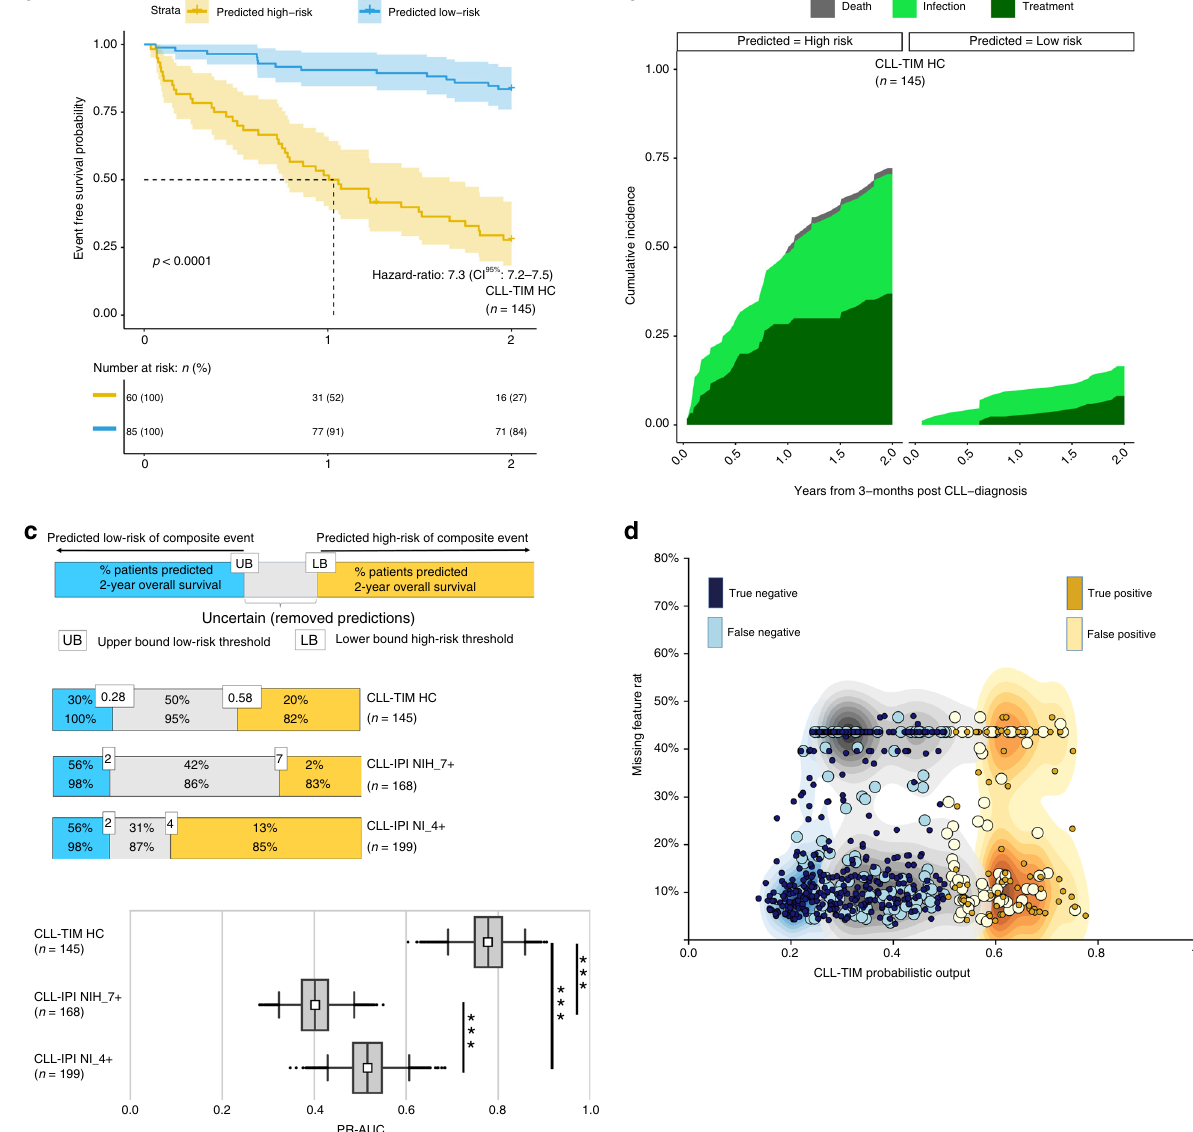
Fig. 3 CLL-TIM benchmarking on internal test cohort. a Kaplan – Meier graphs of infection-free, CLL treatment-free survival for CLL-TIM high-con fi dence (HC) predicted high-risk (yellow curve with 95% con fi dence intervals) and low-risk groups (blue curve with 95% con fi dence intervals) on a subset of the internal test cohort (BENCH-I, n = 288 with n = 145 high-con fi dence predictions). Patients in BENCH-I have full CLL-IPI and a full 2-year follow-up. p -value is by log-rank test. b Cumulative incidence plots for CLL-TIM HC predicted high-risk and low-risk groups for CLL treatment (dark green), infection (bright green) and death (grey) as fi rst events on BENCH-I. c Two-year outcome PR-AUC (Precision-Recall Area-Under-Curve) for CLL-TIM and CLL-IPI on BENCH-I. To allow for an equitable comparison, CLL-TIM HC (i.e. with removal of uncertain predictions) was benchmarked against an additional two versions of CLL-IPI score; CLL-IPI with removal of patients in the intermediate-risk category, CLL-IPI NI_4 + , and CLL-IPI with removal of the intermediate and high-risk category, CLL-IPI NIH_7 + . For box-and-whisker plots, whiskers are 95% con fi dence intervals generated using 5000 bootstrapped datasets sampled from each respective cohort (See Methods), white square is the mean, centre line is the median, bounds of box are the interquartile range and black dots are outliers. We performed model comparison using a one-tailed Mann – Whitney U-test on the mean difference of the PR-AUC over the bootstrapped datasets. *** indicates p < 0.0005. d Average missing feature rate for patients in internal test cohort. Shaded distributions are blue – low-risk high-con fi dence predictions, gray – low-con fi dence predictions, gold – high-con fi dence high-risk predictions. Missing feature rate is the percentage of CLL- TIM ’ s 228 features that were missing for the given patient. Data shown for CLL-TIM ’ s predictions on the internal Danish test cohort ( n =